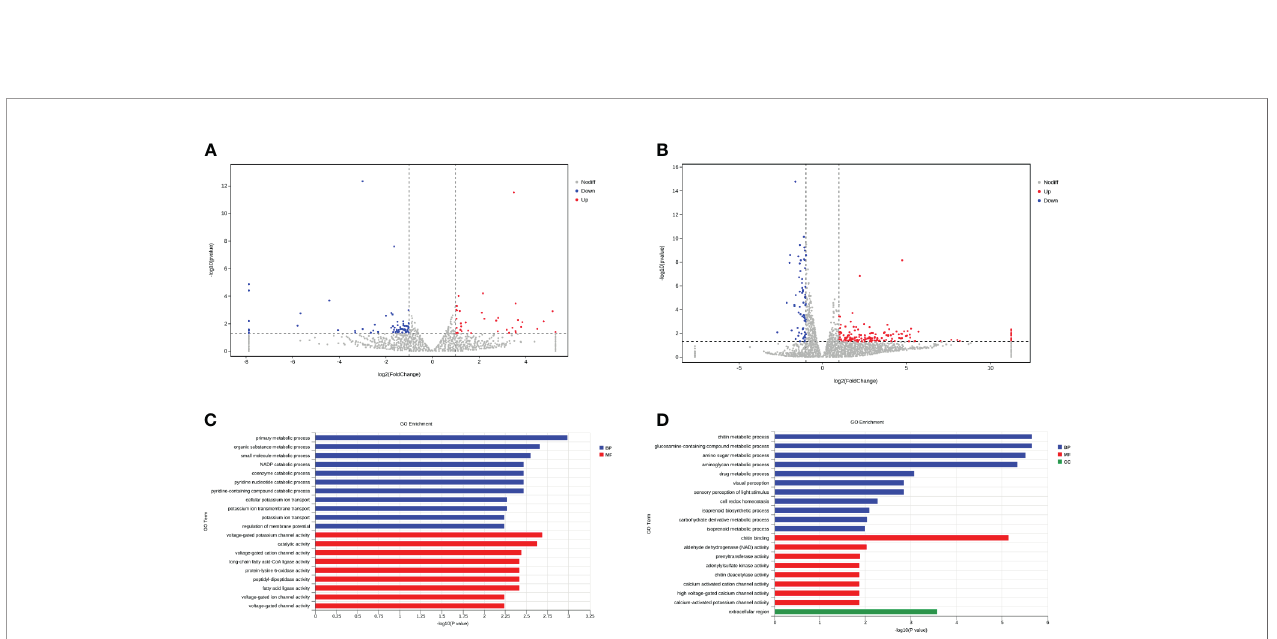
FIGURE 5 | Tick microbiota dysbiosis regulates the gene expression of the tick gut. (A, B) Volcano plots of differentially expressed genes between the AT adults and CT adults under negative mode (A) and positive mode (B) . The up-regulated genes and down-regulated genes are shown in red and blue, respectively. (C, D) GO term assignments for DEGs between AT adults and CT adults under negative mode (C) and positive mode (D) . The abscissa indicates the number of unigenes in the secondary GO classi fi cation, and the ordinate indicates the secondary GO classi fi